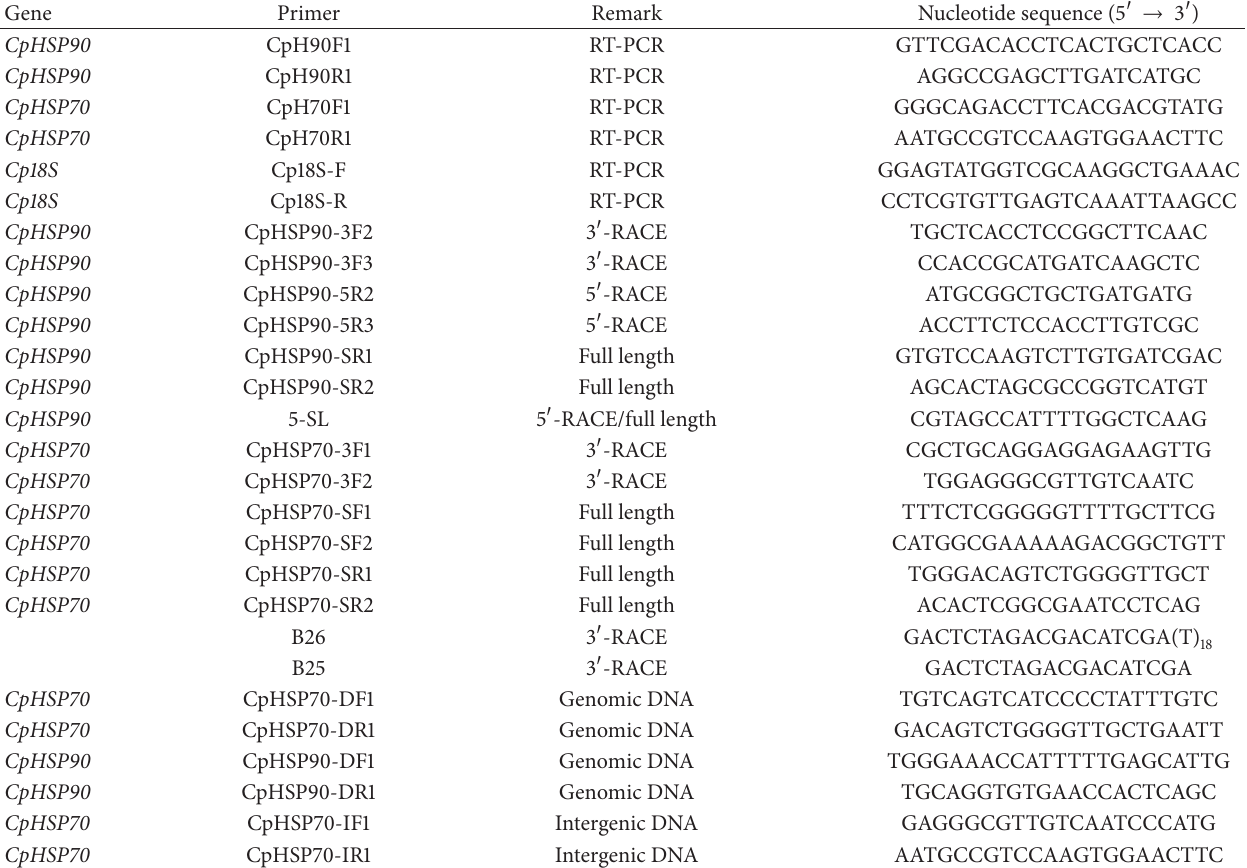
Table 1: The primers used in the present